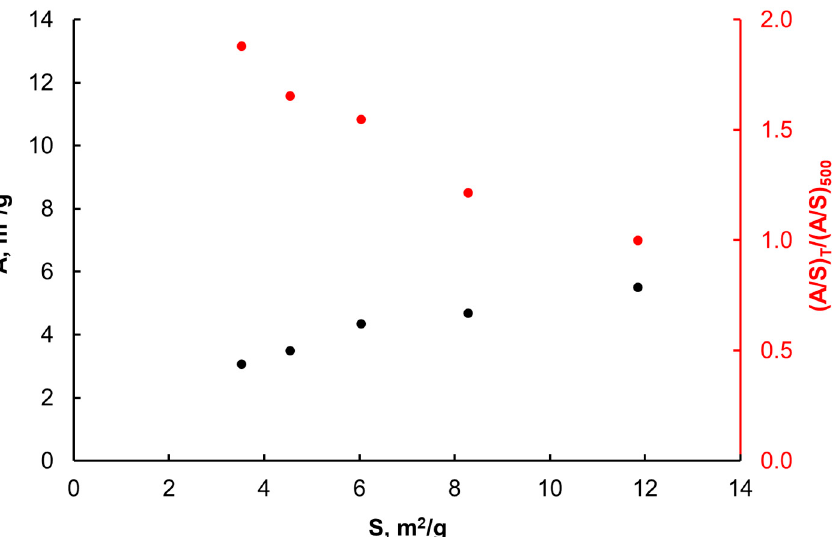
Figure 7. Values of the active specific areas A calculated with the use of measurements of the catalytic decomposition rates of ammonia and ratios of (A/S) T /(A/S) 500 for samples reduced and annealed in hydrogen at various temperatures in the range 500–700 °C as a function of the specific surface area S.